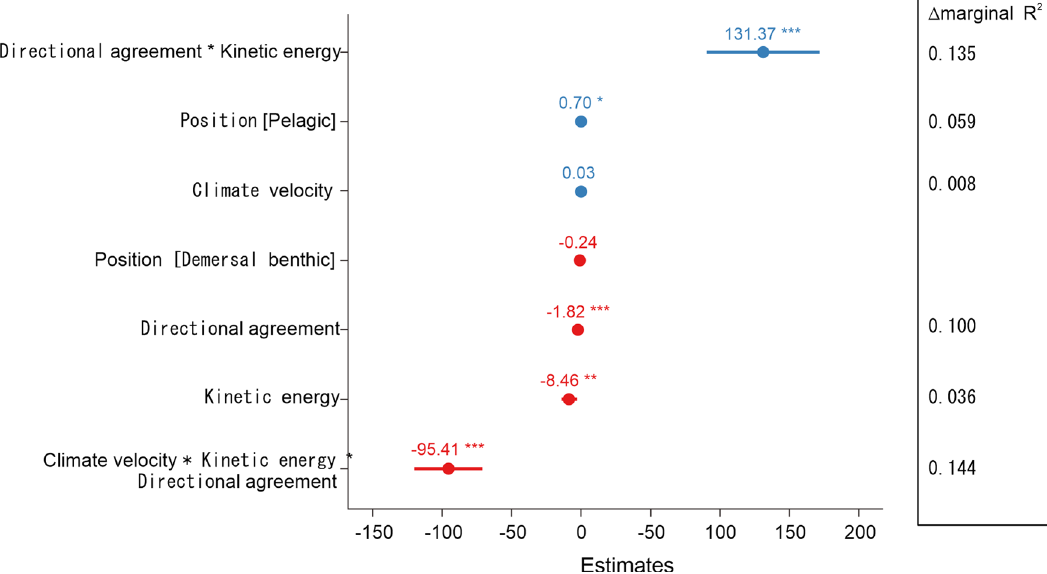
Fig. 4 Regression coef fi cients and relative change in marginal R 2 for the terms retained in the fi nal model for prediction of maximum annual extension distances along the coast. Estimates of regression coef fi cients with corresponding 95% con fi dence intervals for each main and interaction term retained in the fi nal log-linked generalized linear mixed model (GLMM). Regression coef fi cient estimates are on a log 10 scale. The inset panel shows relative change in marginal ( fi xed effect) R 2 resulting from the removal of that particular term from the fi nal model as an indication of its relative contribution towards the total observed variance in response explained by the selected model. n = 127 maximum annual extension